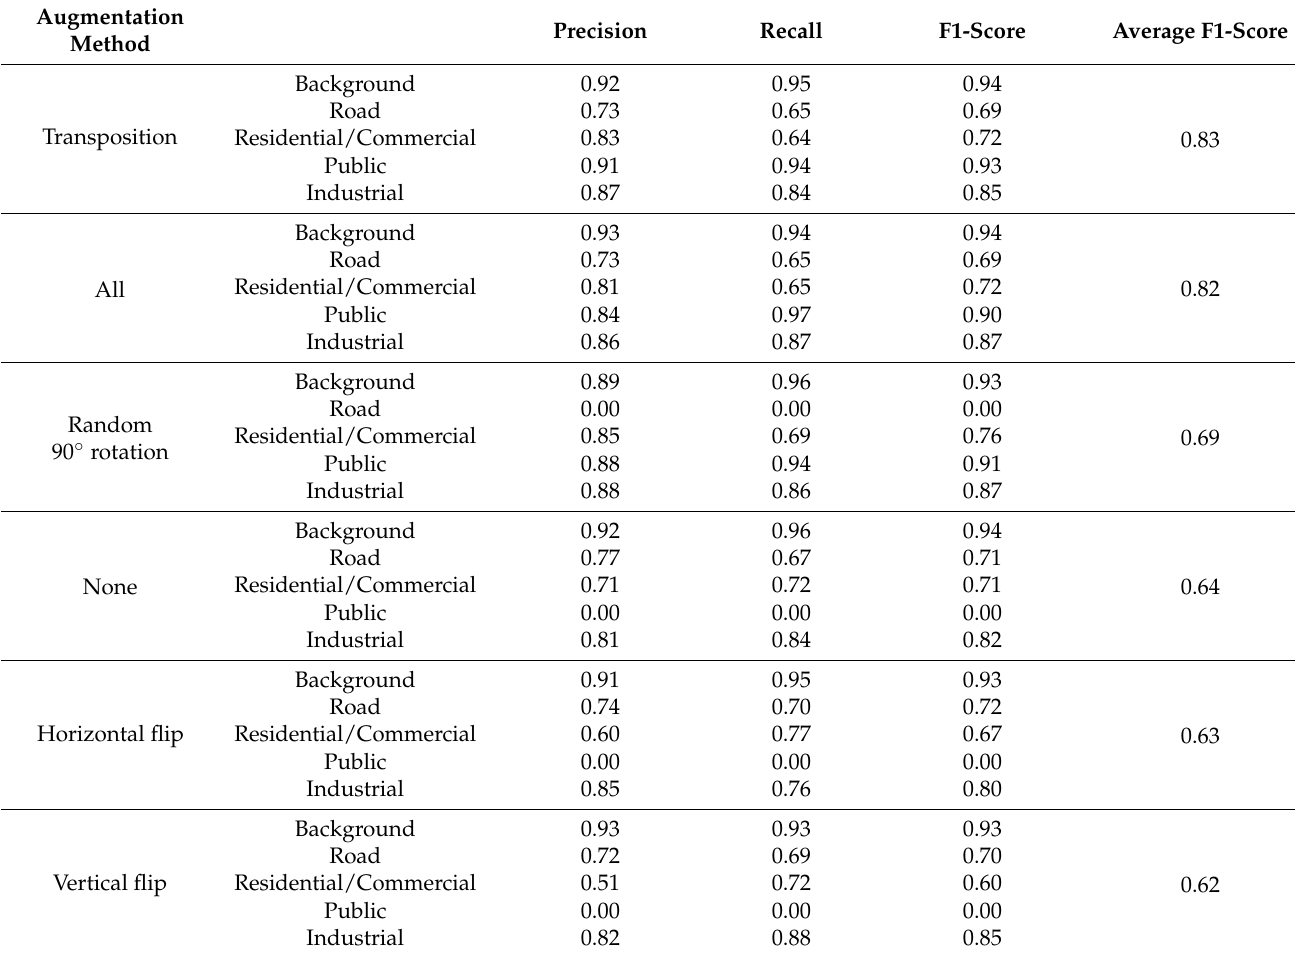
Table 6. Per-class accuracy metrics and average F1 score resulting from augmentation experiment. Table is organized by augmentation method in descending order of average F1